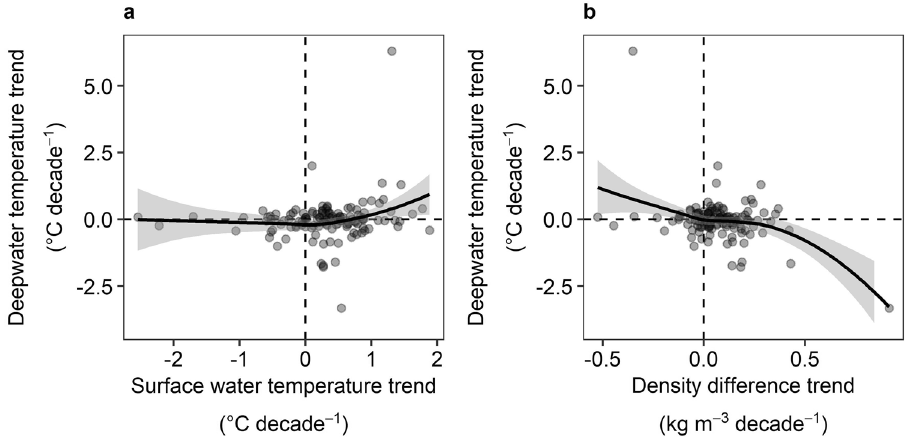
Figure 3. Relationships between deepwater temperature trends vs. surface water temperature trends and density difference trends across lakes. No significant relationship was found between deepwater temperature trends vs. surface water temperature trends ( a ; τ = 0.09, p = 0.12), or vs. density difference trends ( b ; τ = − 0.08, p = 0.17). Smoothed line is a LOESS line with 95% interval bands. Dashed lines indicate the zeroes on the x - and y